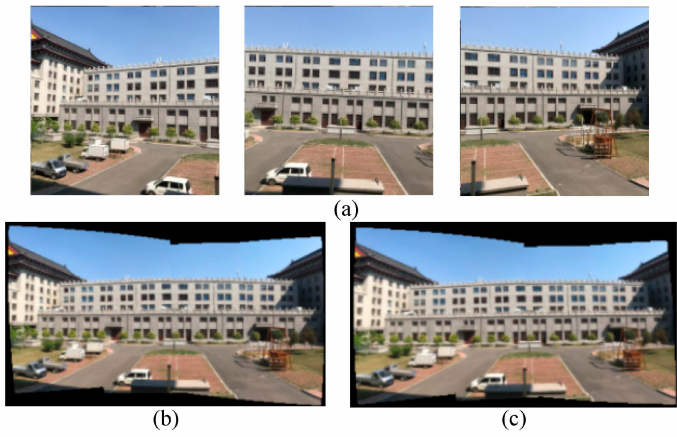
Figure 2. Examination of the feature points efficiency ( a ) the original images; ( b ) the panorama image with 200 feature points; and ( c ) the panorama image with 2000 feature